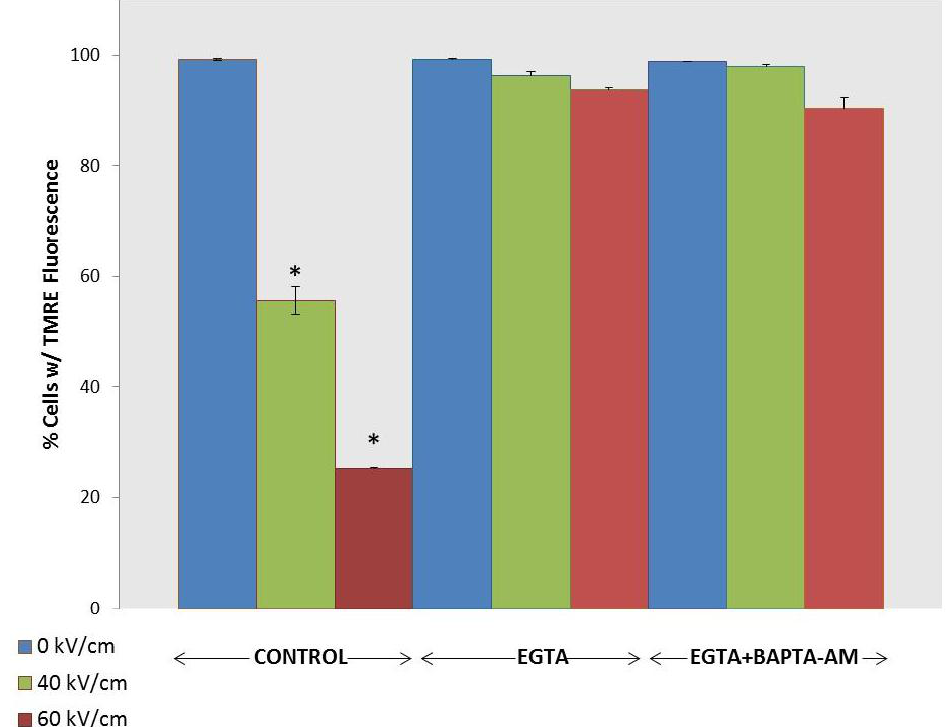
Figure 4. NsPEF- (cid:76)(cid:81)(cid:71)(cid:88)(cid:70)(cid:72)(cid:71)(cid:3)(cid:71)(cid:76)(cid:86)(cid:86)(cid:76)(cid:83)(cid:68)(cid:87)(cid:76)(cid:82)(cid:81)(cid:3)(cid:82)(cid:73)(cid:3)(cid:507)(cid:524)(cid:80)(cid:3)(cid:76)(cid:86)(cid:3)(cid:38)(cid:68) 2+ -dependent. N1-S1 cells were loaded with TMRE as indicated in the Experimental section. Cells were then treated with one 600 ns pulse with a rise-fall time of 15 ns at either 40 or 60 kV/cm or sham treated (0 kV/cm). The Y-axis indicates the percentage of cells that exhibited fluorescence for (cid:55)(cid:48)(cid:53)(cid:40)(cid:3)(cid:68)(cid:86)(cid:3)(cid:68)(cid:3)(cid:80)(cid:72)(cid:68)(cid:86)(cid:88)(cid:85)(cid:72)(cid:3)(cid:82)(cid:73)(cid:3)(cid:507)(cid:524)(cid:80)(cid:15)(cid:3) (cid:90)(cid:75)(cid:76)(cid:70)(cid:75)(cid:3) (cid:90)(cid:68)(cid:86)(cid:3) (cid:71)(cid:72)(cid:87)(cid:72)(cid:85)(cid:80)(cid:76)(cid:81)(cid:72)(cid:71)(cid:3) (cid:69)(cid:92)(cid:3) (cid:73)(cid:79)(cid:82)(cid:90)(cid:3) (cid:70)(cid:92)(cid:87)(cid:82)(cid:80)(cid:72)(cid:87)(cid:85)(cid:92)(cid:3) (cid:20)(cid:19)(cid:3) (cid:80)(cid:76)(cid:81)(cid:88)(cid:87)(cid:72)(cid:86)(cid:3) (cid:68)(cid:73)(cid:87)(cid:72)(cid:85)(cid:3) treatment in the presence or absence of BAPTA- (cid:36)(cid:48)(cid:3)(cid:11)(cid:21)(cid:19)(cid:3)(cid:541)(cid:48)(cid:12)(cid:3)(cid:68)(cid:81)(cid:71)(cid:18)(cid:82)(cid:85)(cid:3)(cid:40)(cid:42)(cid:55)(cid:36)(cid:3)(cid:11)(cid:24)(cid:3)(cid:80)(cid:48)(cid:12)(cid:17)(cid:3)(cid:55)(cid:75)(cid:72)(cid:3) symbols indicate treatments that were significantly different (p < 0.05, n = 3) from sham treatment (0 kV/cm). There were no significant difference between treatments with EGTA and EGTA/BAPTA-AM compared to sham treated controls (0